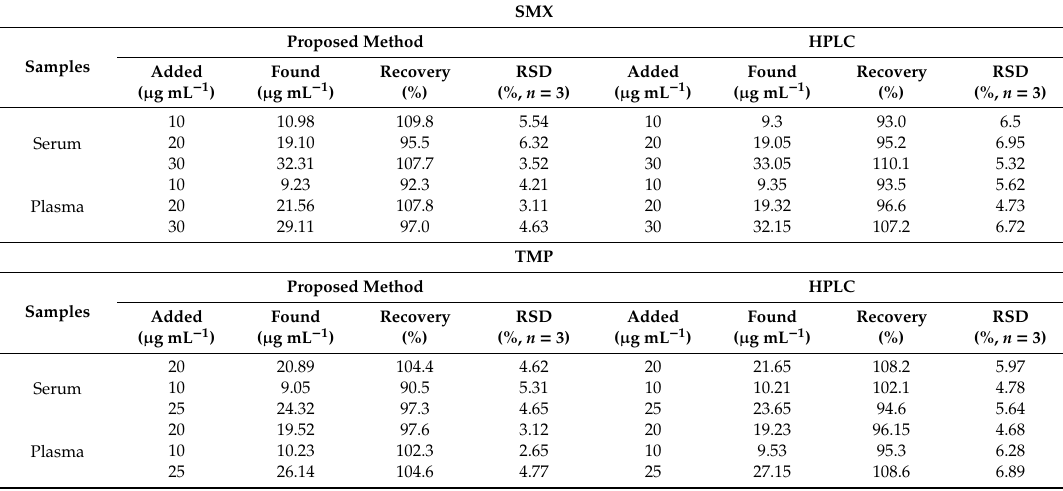
Table 4. Results of the replicate measurements ( n = 3) for the determination of SMX and TMP in biological